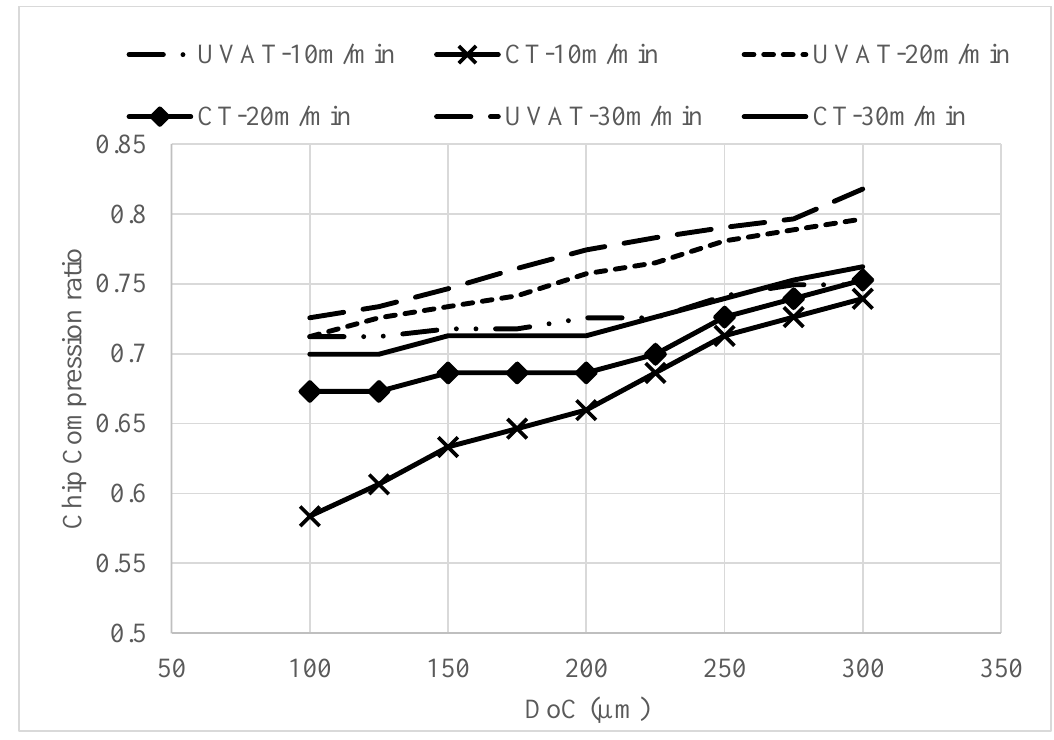
Figure 8. The predicted Ra in UVAT and CT.